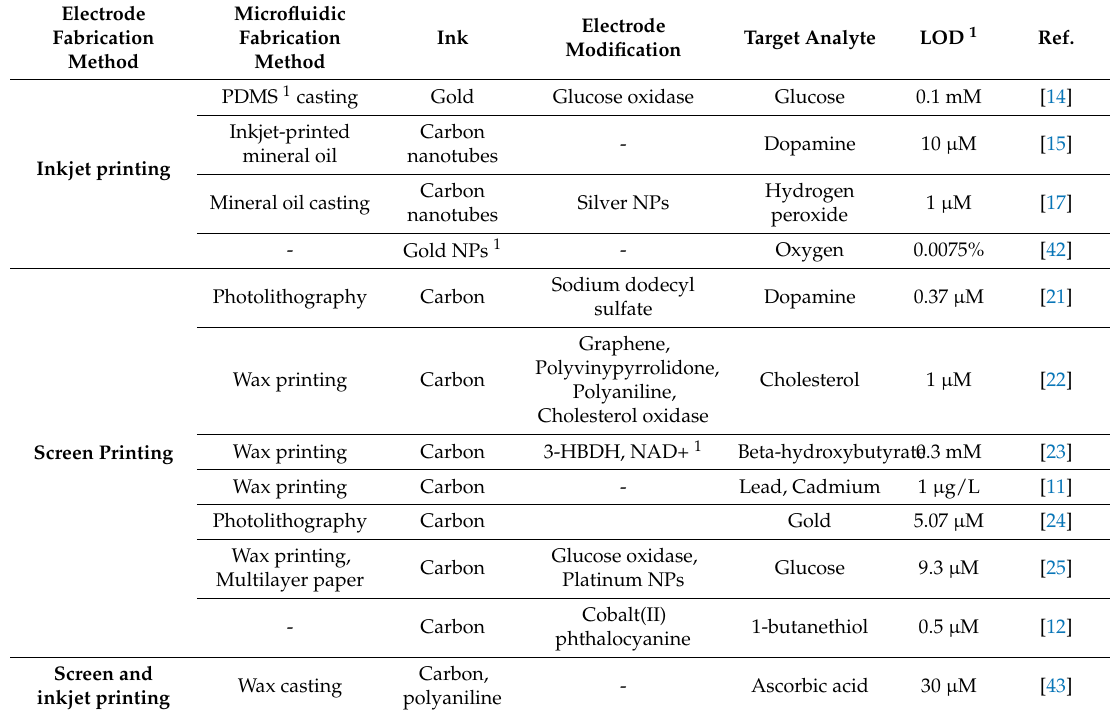
Table 1. Summary of previous works on paper-based electrochemical